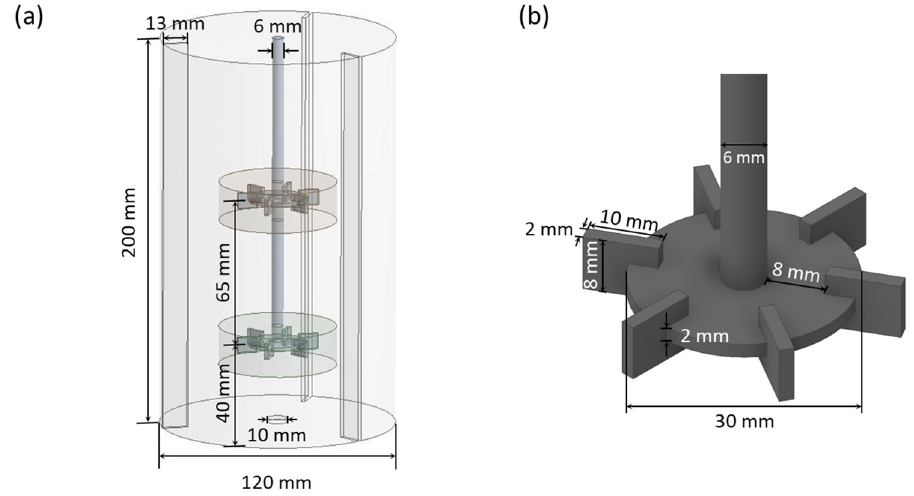
Figure 1. Schematic illustration of a ( a ) stirred tank and ( b ) Rushton turbine. Around 350,000 total computational nodes were created to ensure grid